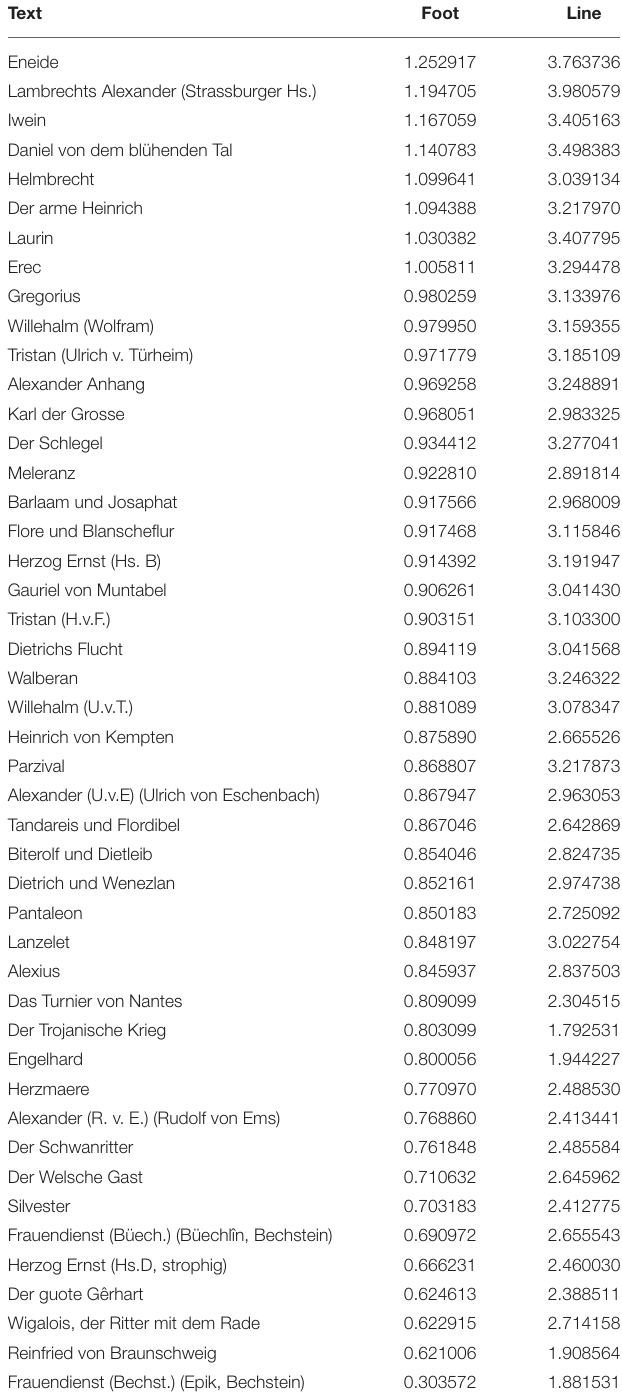
TABLE 15 | Shannon entropy for 1,000 random line